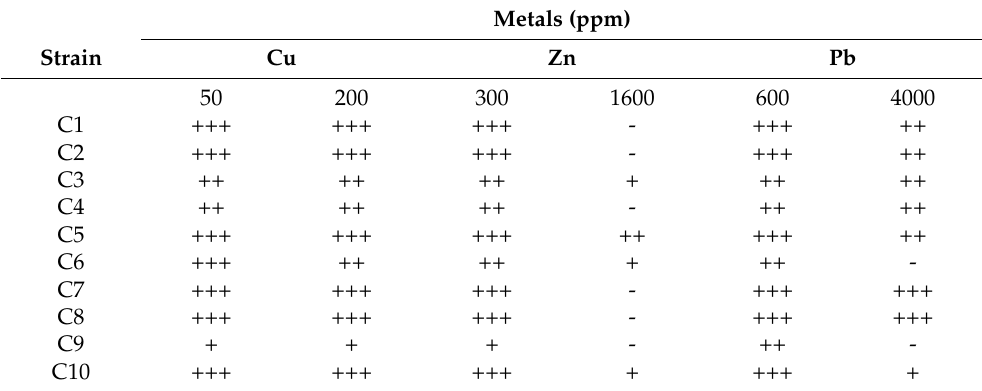
Table 1. Endophyte growth test with heavy metals (Cu, Zn, Pb) under two extreme concentrations for each